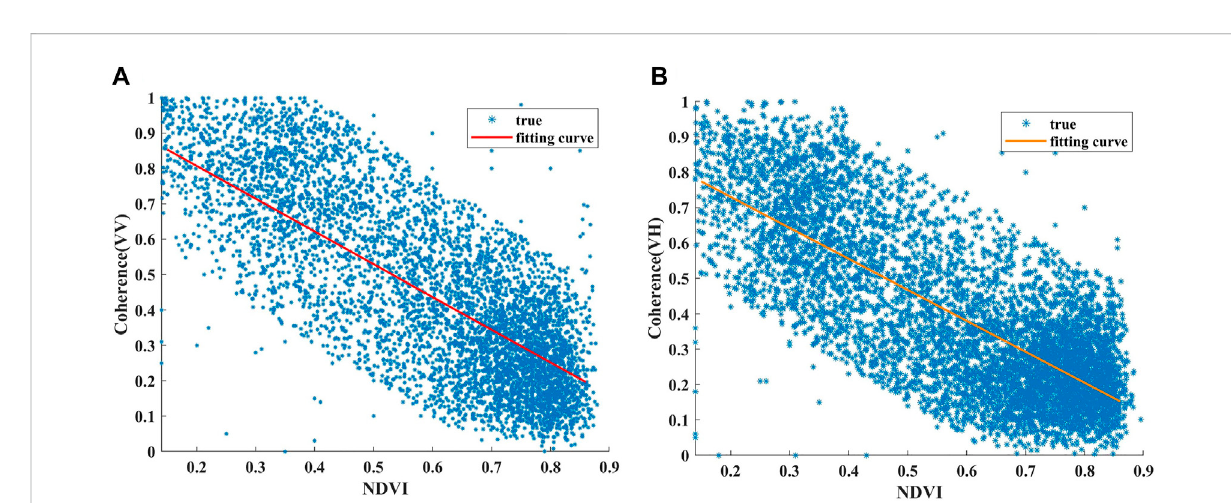
FIGURE 7 Relationship between the Landsat8-derived NDVI and Sentinel-1A coherence (A) VV channel (B) VH